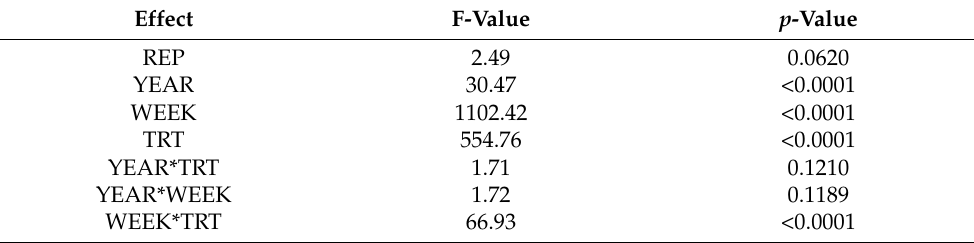
Table 5. Analysis of variance with respect to cover crop mixture